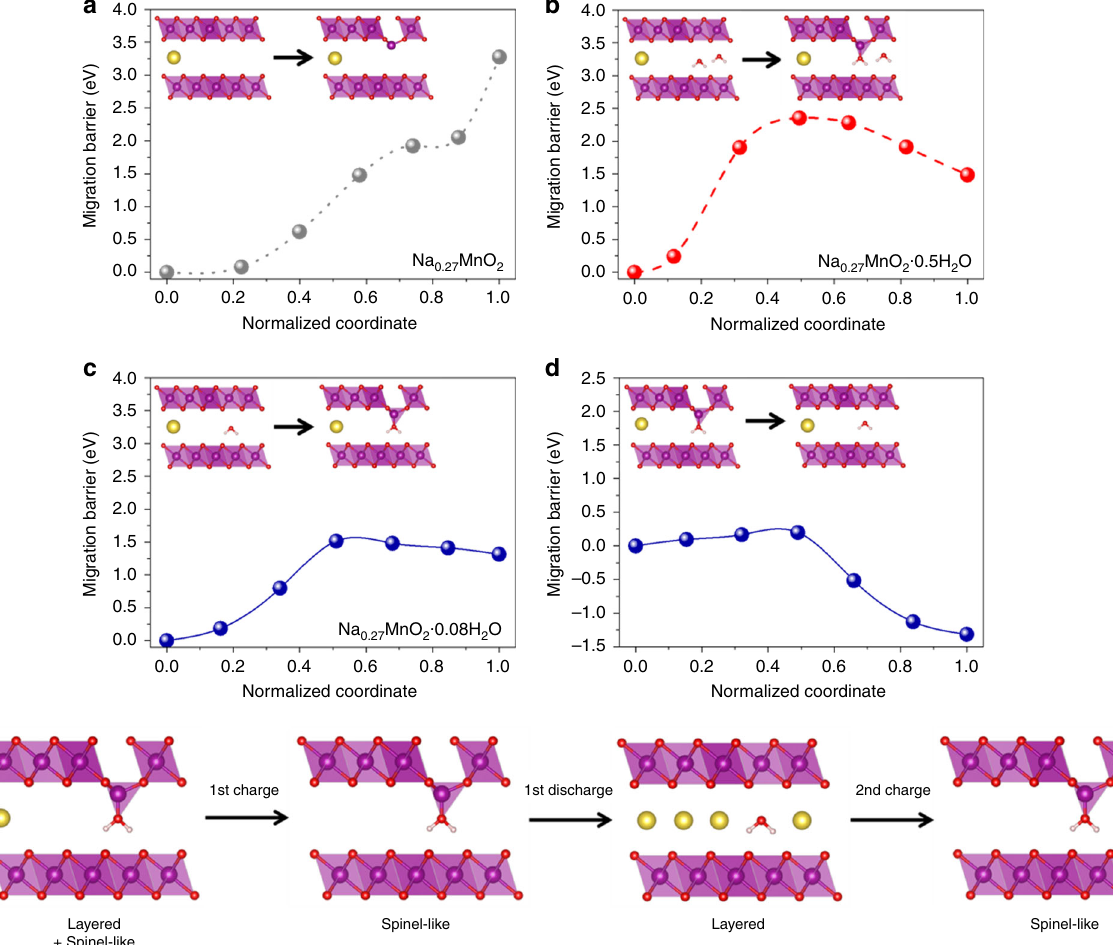
Fig. 4 Calculations of Mn ion migration barriers depending on the contents of crystal water. Migration barriers of Mn ions from octahedron in Mn layer to tetrahedron in Na layer in a Na 0.27 MnO 2 , b Na 0.27 MnO 2 ·0.5H 2 O, c Na 0.27 MnO 2 ·0.08H 2 O, and d Migration barrier for the reverse process in Na 0.27 MnO 2 ·0.08H 2 O. e Schematic illustration for the reversible structural changes of partially dehydrated Na-bir during Na ion